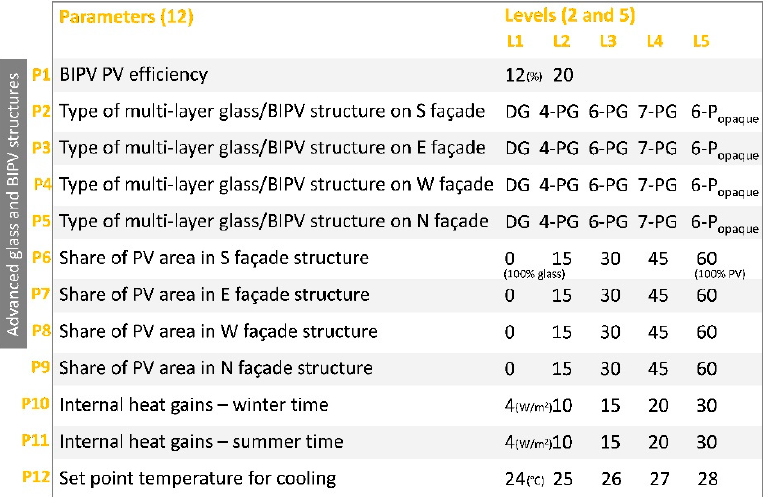
Figure 2. Chosen influential parameters and their levels for evaluation of building constructed with advanced glass and building integrated photovoltaics facade (BIPV) facade structures.